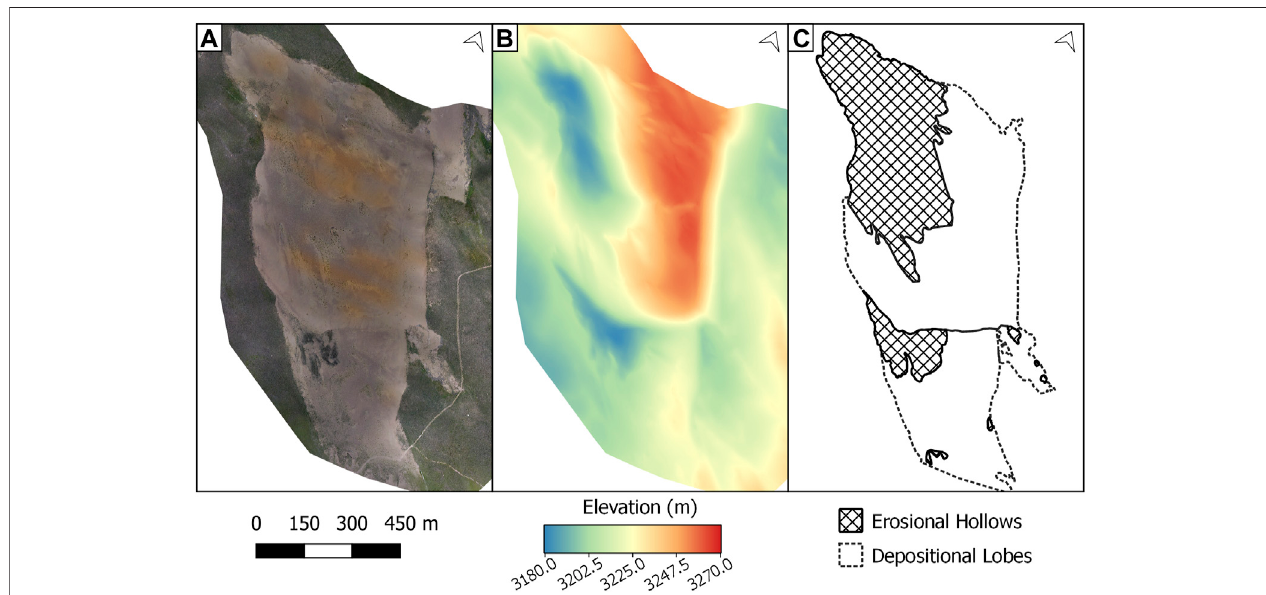
FIGURE 10 | A complex mega-blowoutviewed as ( A ) a true color composite; ( B ) a digital elevation model derived from Structure-from-Motion modeling; and ( C ) a schematic model demarcating erosional hollows and depositional lobes. Note in fi lling of downwind erosional hollows and large slope gradients. Coordinates of the top- left corner of the bounding box: 35.8610N, 100.2761E; bottom-right corner: 35.8516N, 100.2913E.